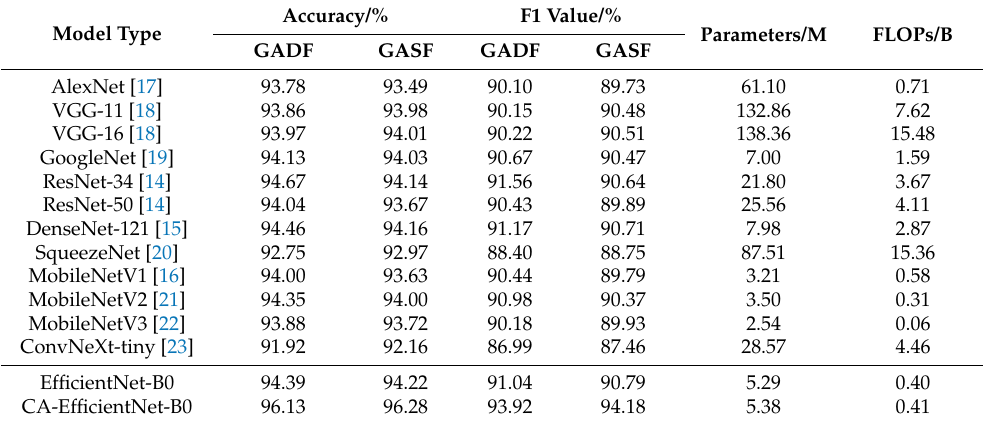
Table 5. Performance comparison of each network model on GADF and GASF